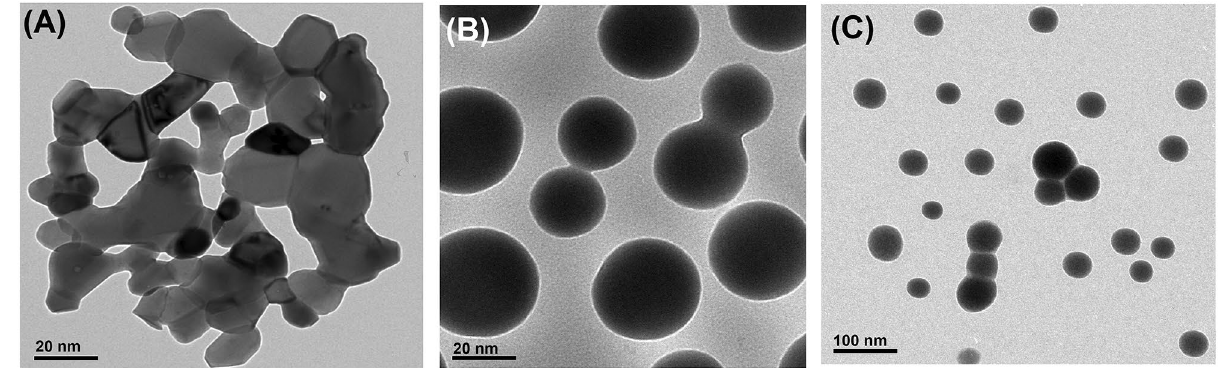
Figure 2. TEM images of the myco-fabricated CoFeNPs ( A ), SeNPs ( B ), and ZnONPs ( C ).